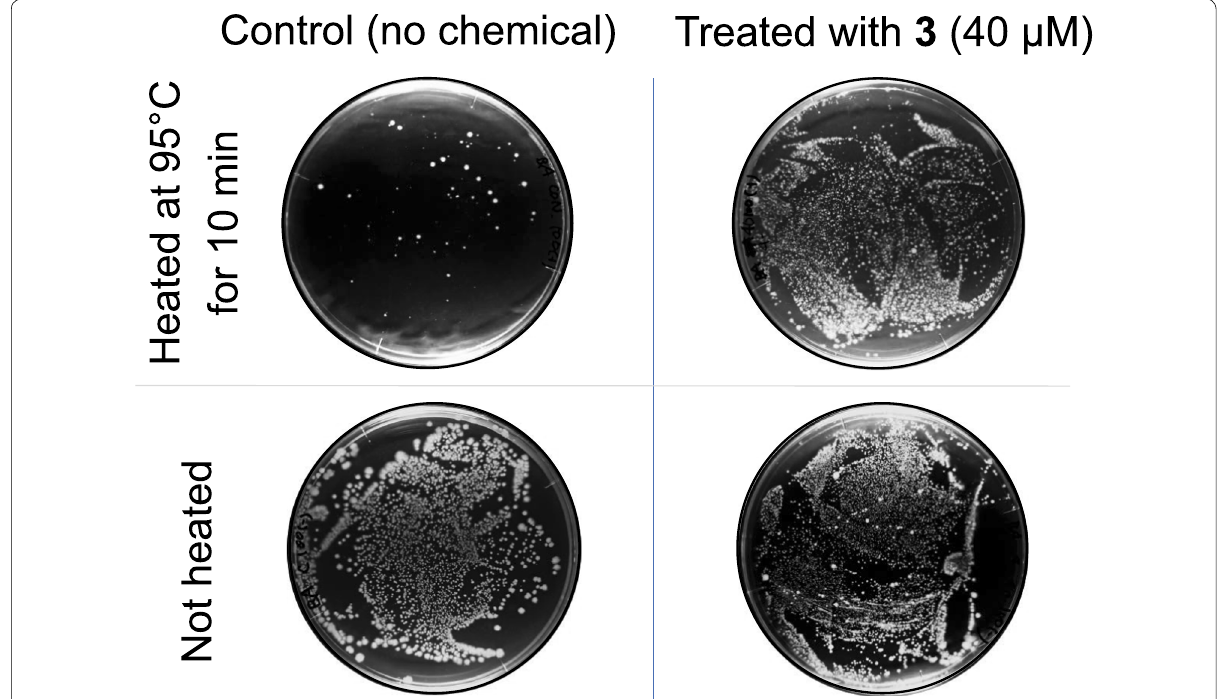
Fig. 4 Heat-tolerant assay for sporulated B. amyloliquefaciens AHU 2170 with diacetone acrylamide. A 50 µL portion of bacterial cell suspension exposed to 40 µM diacetone acrylamide, incubated for 48-h, and 100-times diluted with Milli-Q water, was kept at 95 °C for 10 min and spread over a 9-cm nutrient broth agar plate. Incubation at 30 °C for 48 h. Two “control” plates ( left ) are without any chemical treatments, while two plates of “not heated” ( bottom ) are without heating